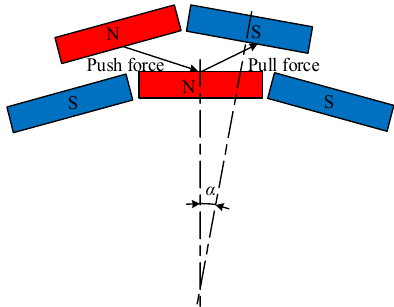
Figure 2. Sketch of magnetic forces between gears with a torque angle.